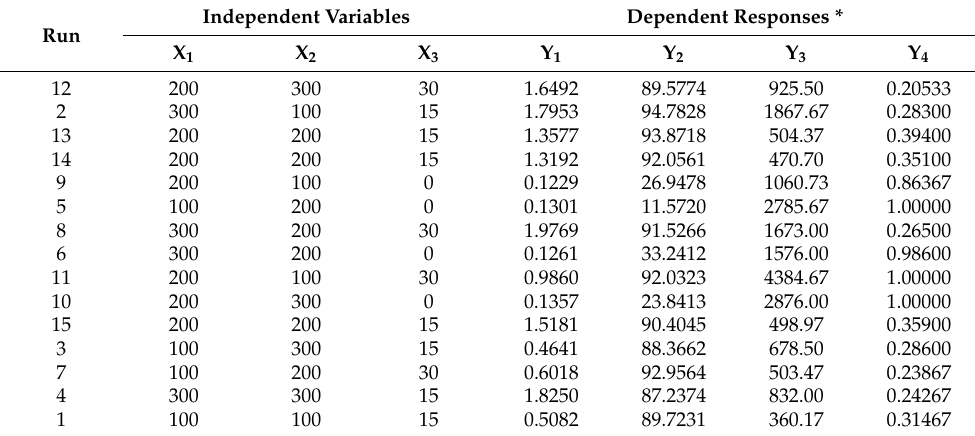
Table 5. The Box–Behnken experimental designs and